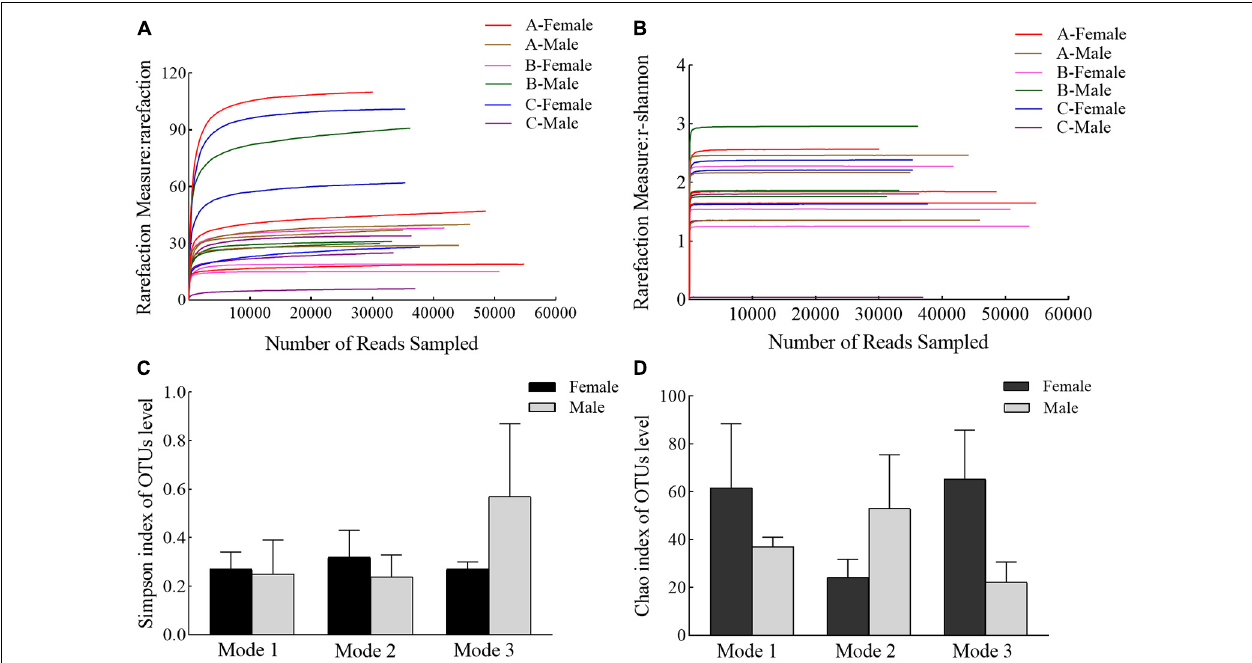
FIGURE 3 | Alpha diversity comparisons of the stomach contents of juvenile Eriocheir sinensis reared under different feeding modes. (A) Rarefaction curve, (B) Shannon-Wiener curve using Shannon’s index as the metric for crab fed with various diets, (C) Simpson’s diversity indices in different feeding modes, and (D) Chao’s species richness indices in different feeding modes. Values on the bar graph represent the average; error bars represent the standard deviation ( n = 9). Mode 1, 2, and 3 represent traditional, formulated, and mixture feeding modes, respectively.